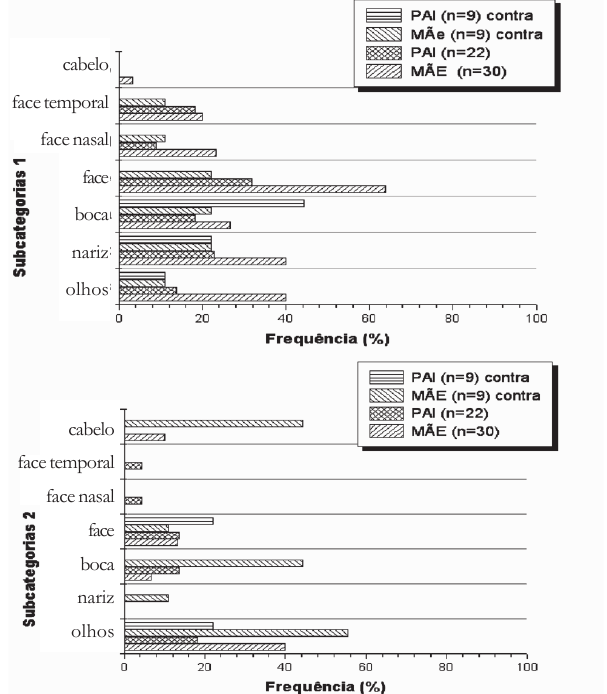
Figura 4. Porcentagens de ocorrência nas subcategorias 1 e 2. As condições no ponto cego e contralateral ao ponto cego são comparadas para mãe e pai.